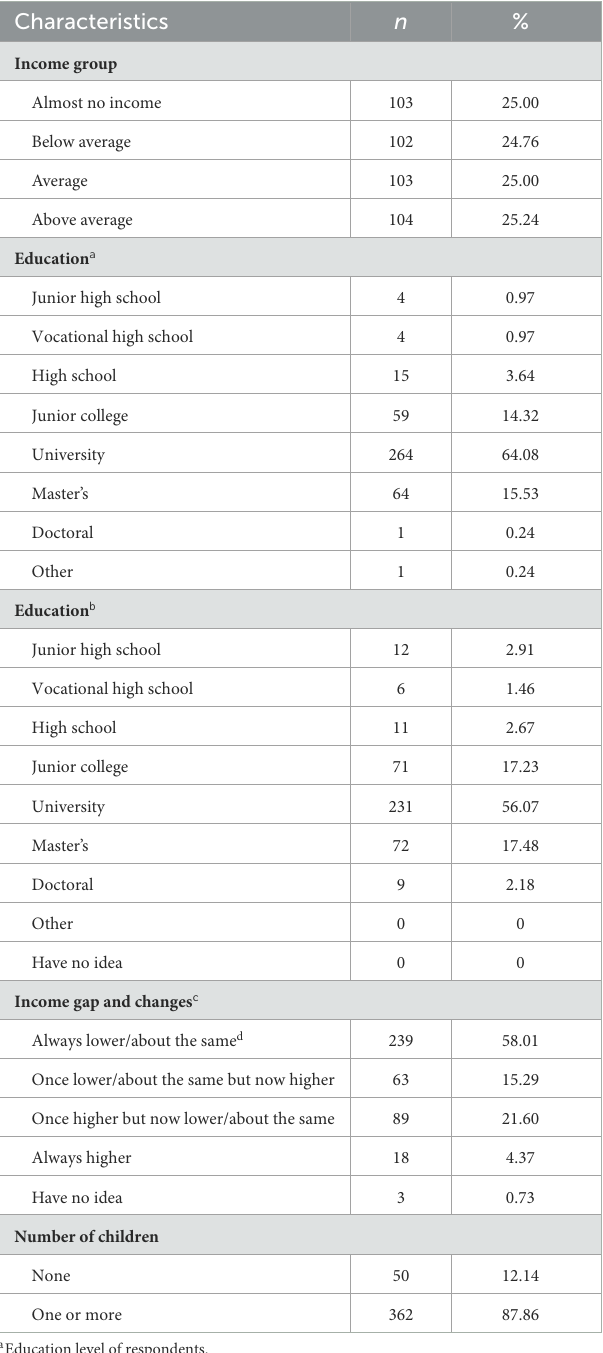
TABLE 3 Basic information of the